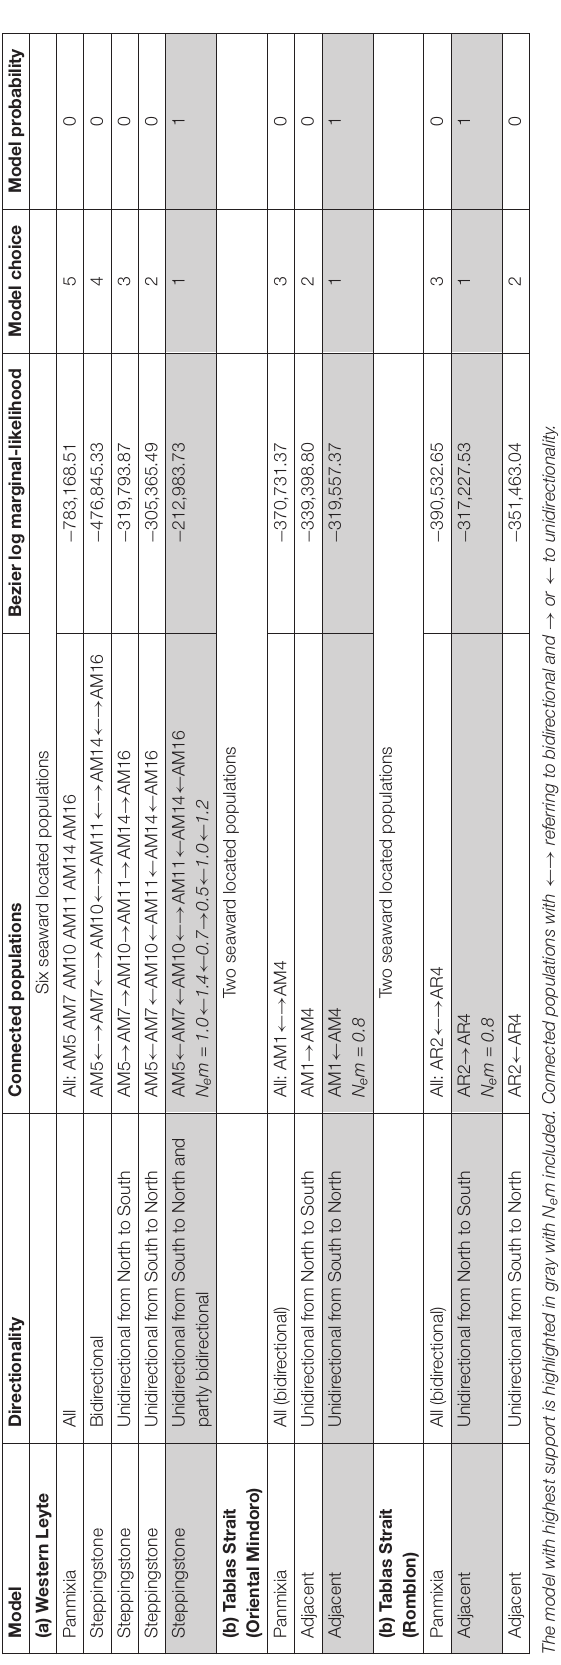
different dynamics in estuarine ecosystems. Encroachment and fragmentation usually start from landward sides. Knowing that the regeneration of mangrove forests primarily depends on